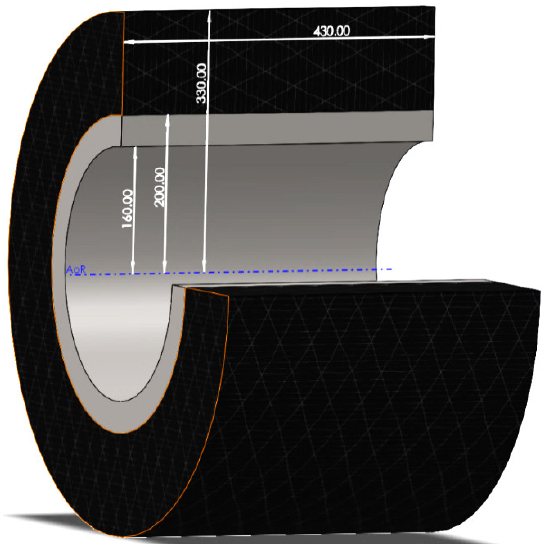
Figure 1. Simulated flywheel rotor showing dimensions of metallic hub and carbon fiber rim. The axis of rotation (AoR) is shown in blue.